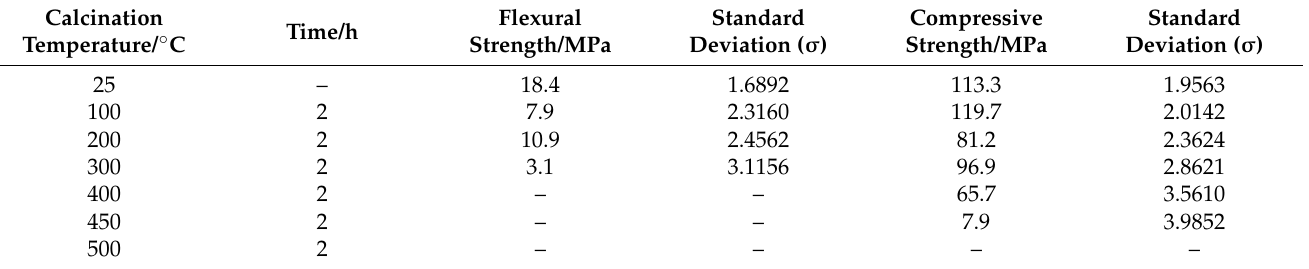
Table 3. Effects of calcination temperature on mechanical properties of magnesium oxychloride